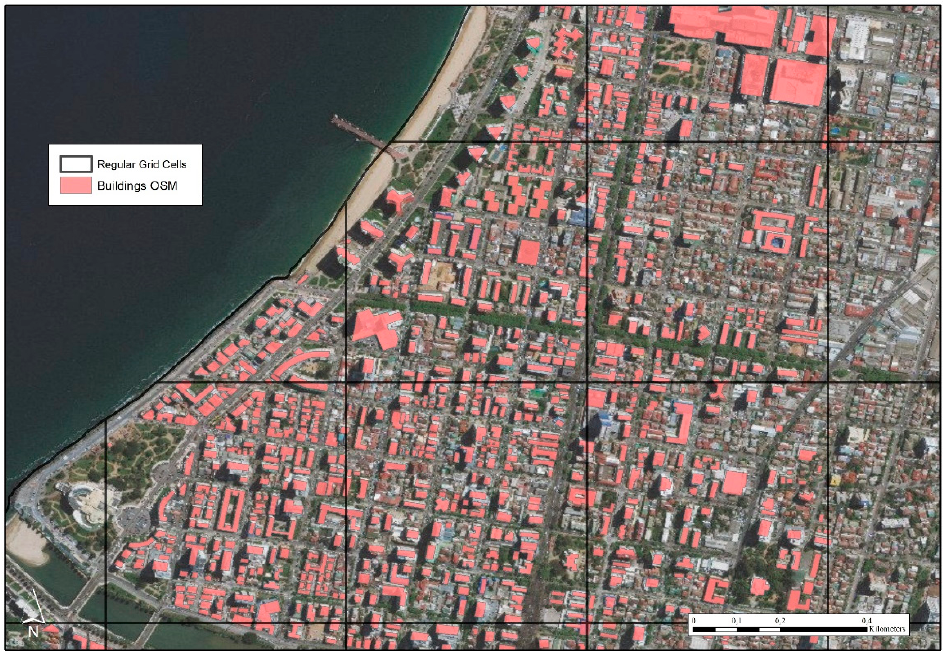
Figure 8. Building footprints for a certain area in Valparaíso (© OpenStreetMap contributors 2021), distributed under the Open Data Commons Open Database License (ODbL) v1.0. Map data © Google Earth 2020. Figure reprinted from [50].